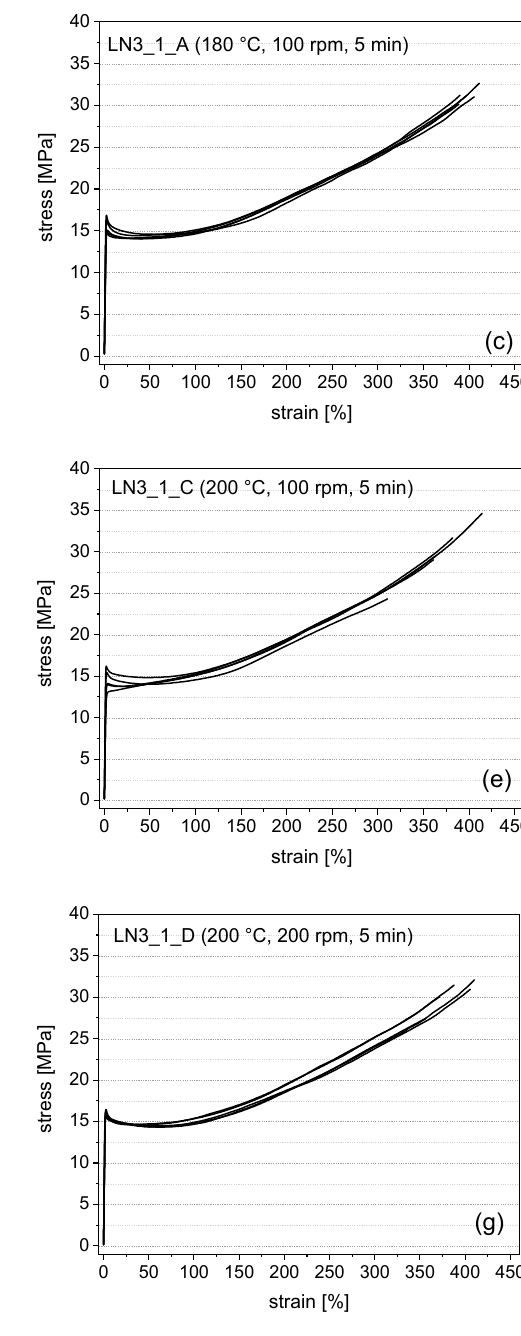
Figure A1. Stress-strain diagrams of pure LN3 and respective composites with 1 wt% of MWCNTs: ( a ) LN3_neat, ( b ) LN3_A, ( c ) LN3_1_A, ( d ) LN3_C, ( e ) LN3_1_C, ( f ) LN3_D, and ( g ) LN3_1_D .